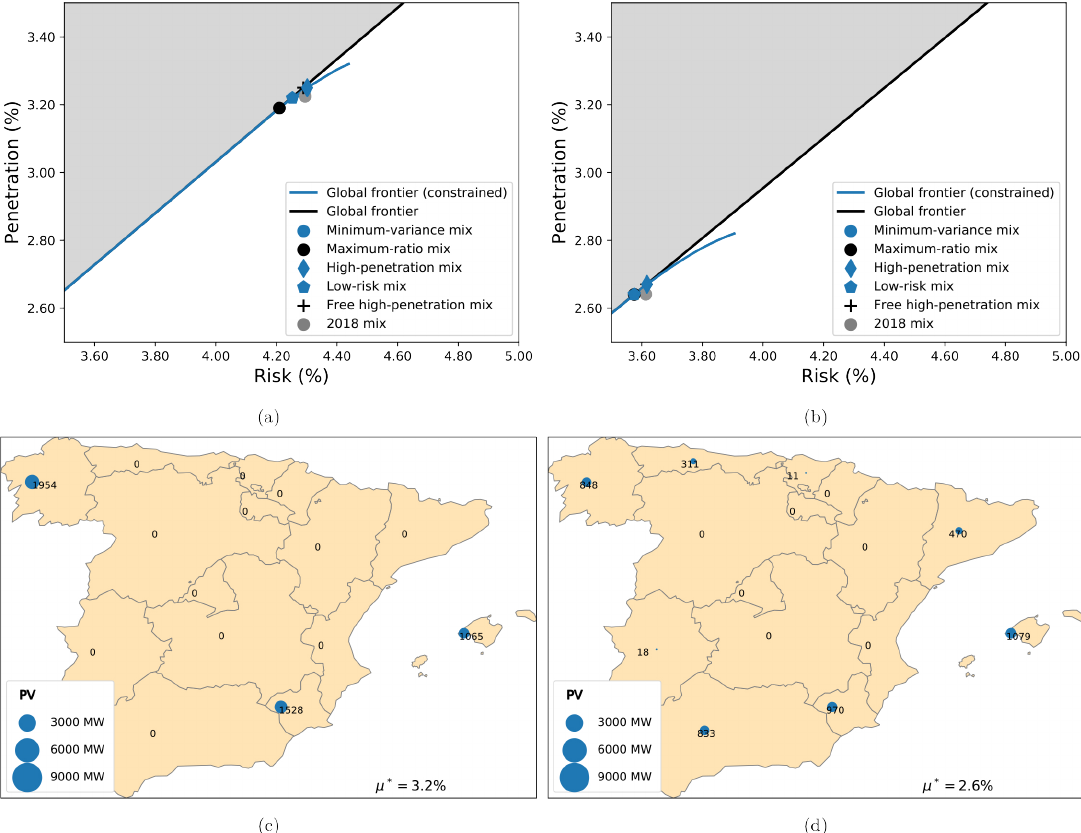
Figure 5. Penetration-risk diagram ( a , b ) and high penetration mix ( b , d ) for CTL/PVCS ( a , c ) and CTL/PVOR ( b , d